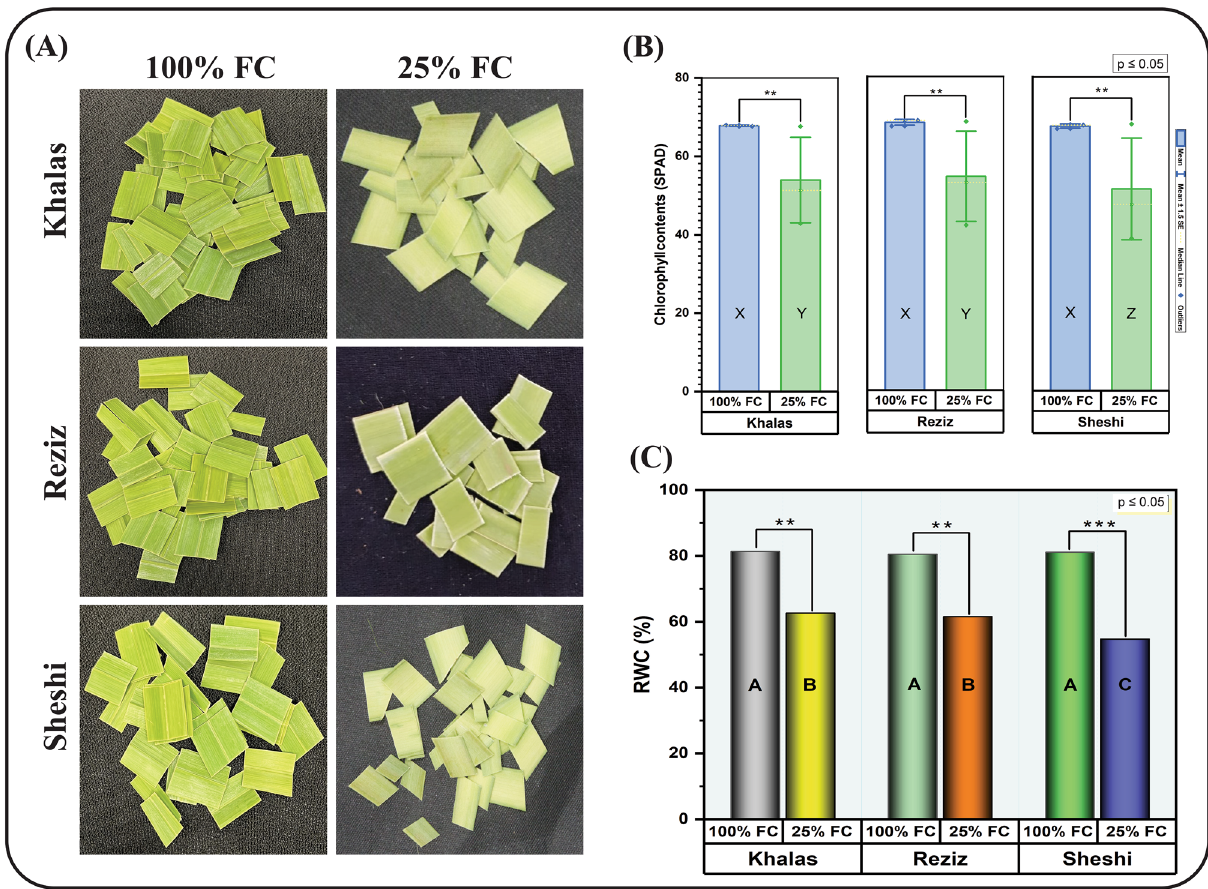
Figure 1. Phenotype exhibited by date palm leaves ( A ), chlorophyll contents ( B ), and relative water contents ( C ) at 100% and 25% field capacity. Bar graph showing different letters are significantly different at p ≤ 0.05, and the asterisk represents the significance of the level of probability. The data presented here represents the chlorophyll content and relative water content recorded after 90 days of drought